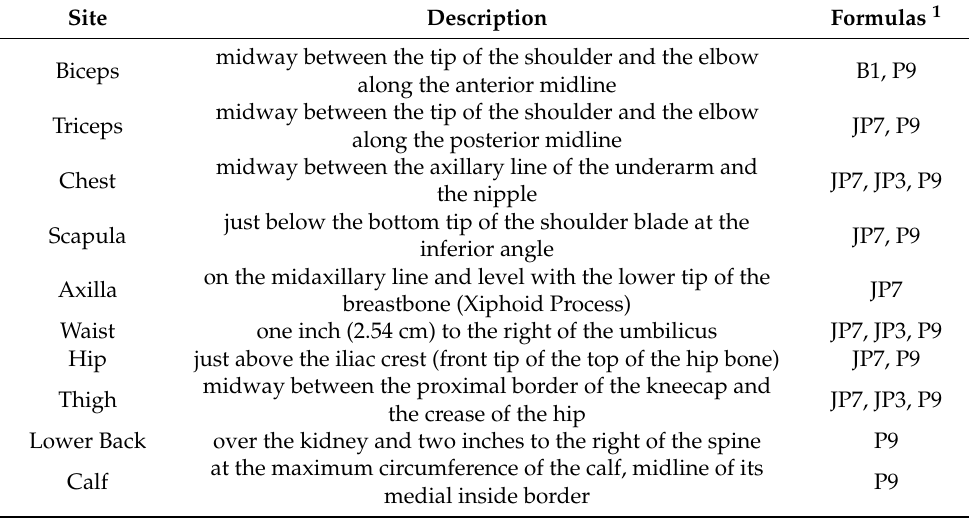
Table 2. Anatomic sites for subcutaneous adipose tissue layer thickness measurements required by the evaluated formulas, as instructed by the BodyViewProFit software. Site Description Formulas 1